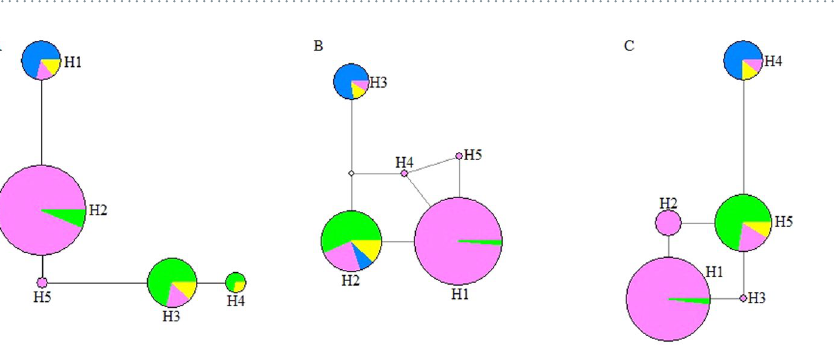
Figure 7. Potential distribution of C. ciliata under current climate conditions. The map is made by ArcGIS 10.2 software, http://www.arcgis.com/features/.